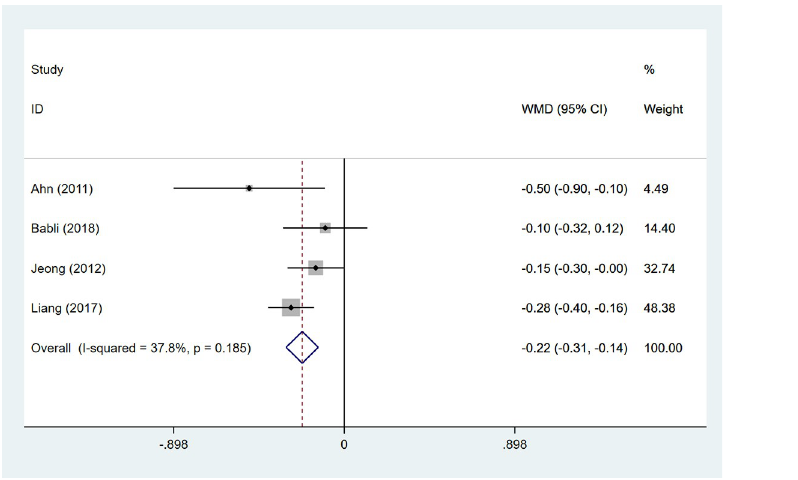
Fig 8. The forest plot of MACIS score between HT group and non-HT